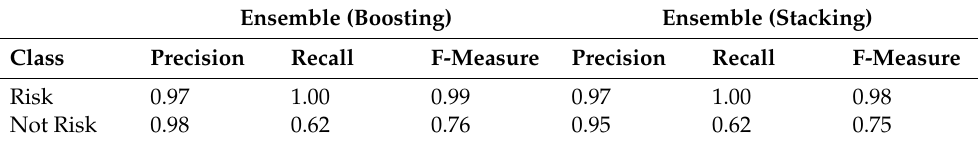
Table 4. Class-wise comparison of Ensemble classifier by Boosting and Stacking with Feature Selection.